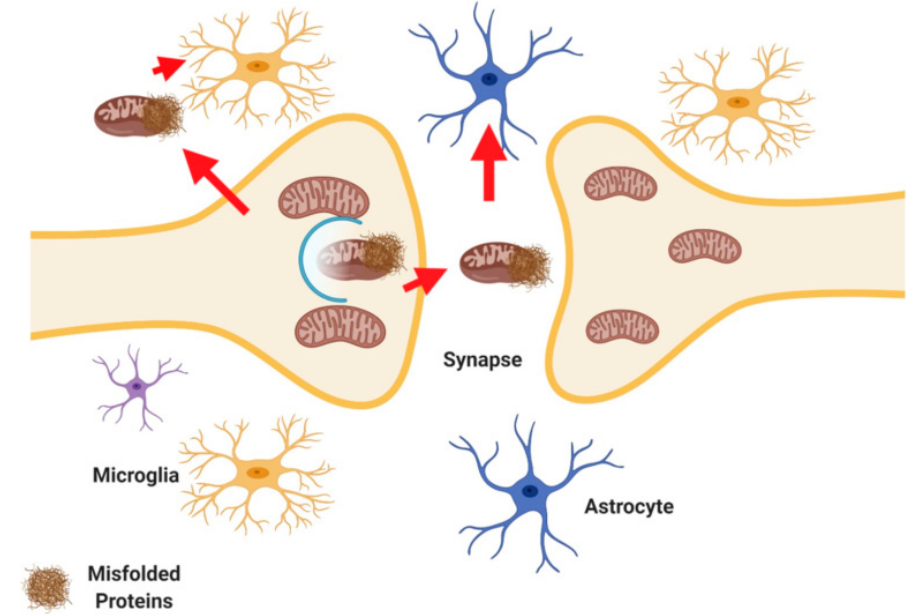
Figure 3. Transcellular Mitophagy. Mitochondria are released at neuronal synapses where they are taken up by glial cells (astrocytes and / or microglia) for degradation [8,9]. Created with BioRender.com.